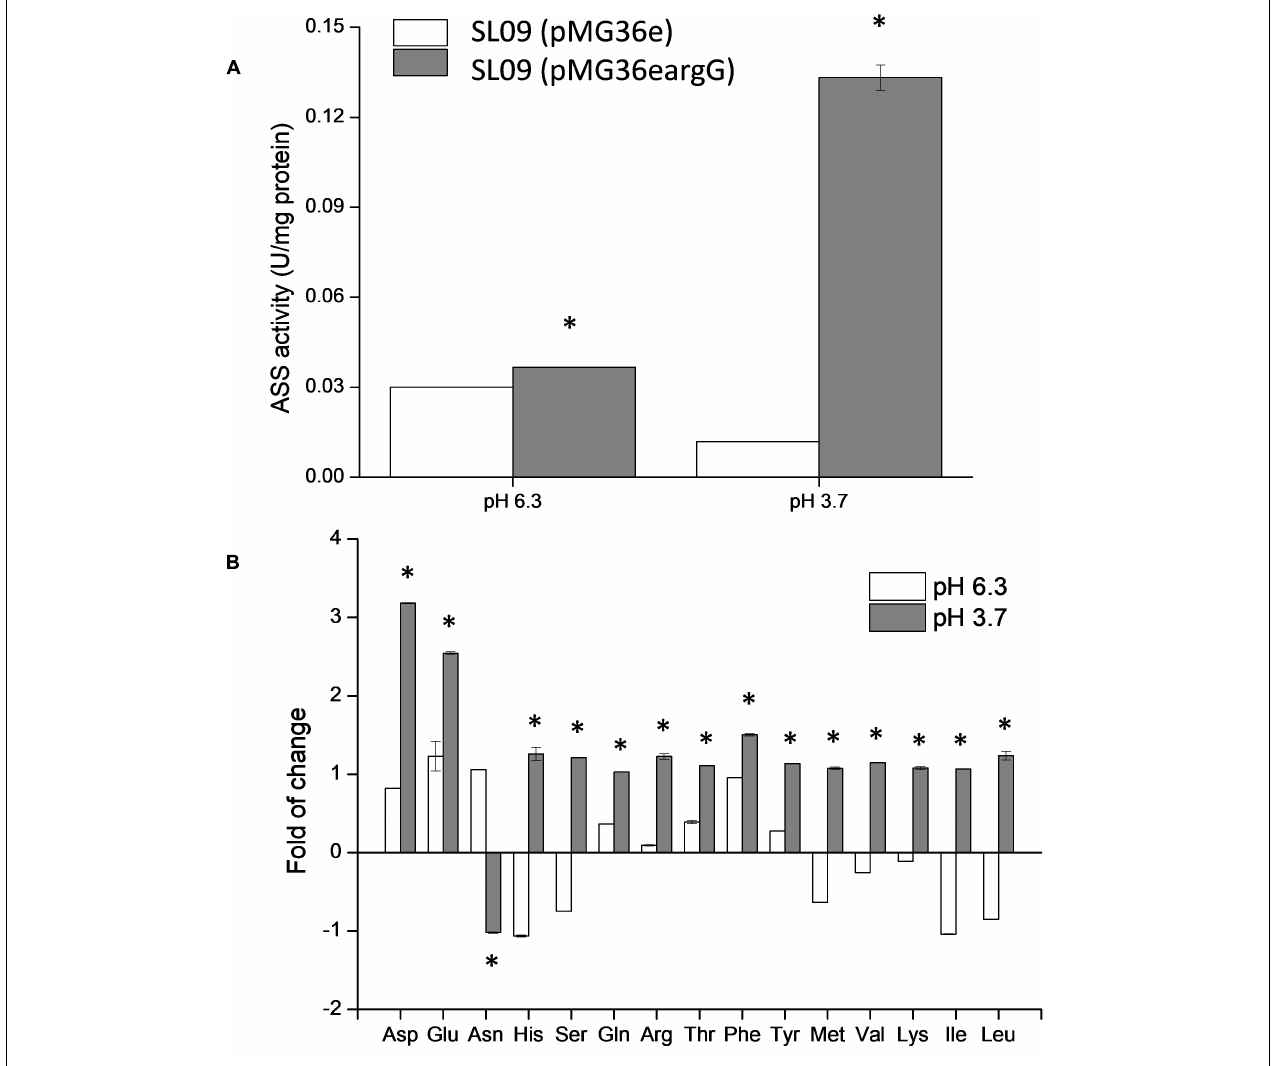
FIGURE 5 | Effect of argG gene heterologous expression on ASS activity (A) and intracellular amino acids (B) . The fold change of intracellular amino acids in the recombinant strain were determined relative to the levels in SL09 (pMG36e) at pH 6.3 and pH 3.7. ∗ Difference significant at 95% confidence